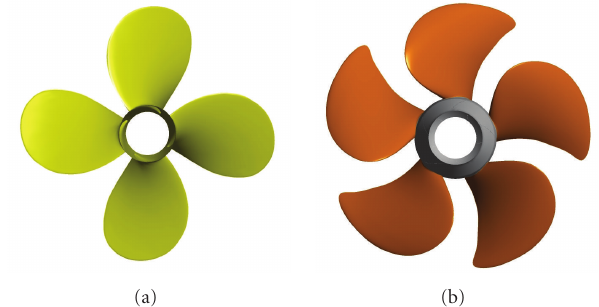
Figure 7: Propellers’ CAD models. View looking downstream. E779A propeller (a), PPTC propeller (b). The propellers’ models are not shown using the same scale.